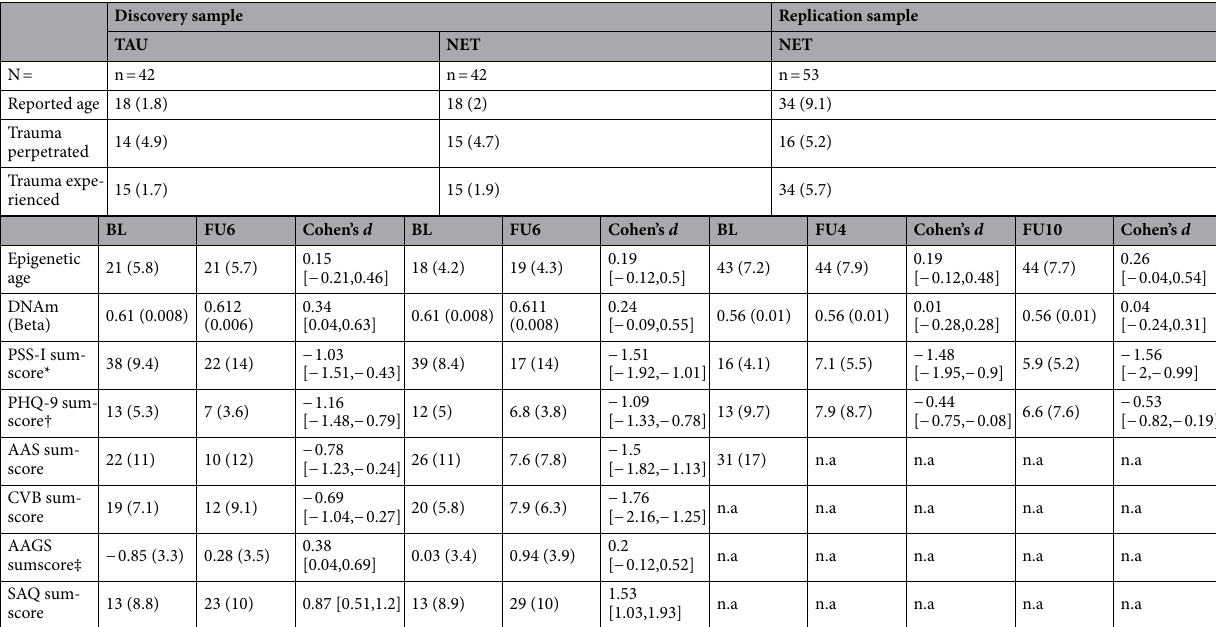
Table 1. Summary statistics of the discovery and replication samples. Sample size, reported age, nr. of traumatic events (perpetrated and experienced), epigenetic age, DNAm (Beta), and sumscores for PTSD (PSS-I), depression (PHQ-9), appetitive aggression (AAS), current violent behaviour (CVB), feelings of guilt (AAGS) and social acknowledgement (SAQ) are shown. Except for sample size, all values are reported as means with standard deviations in parentheses. Cohen’s d effect sizes are reported with a 95% bootstrap confidence interval in square brackets. BL: baseline; FU4,6,10: follow-ups after 4, 6 and 10 months from baseline, respectively; *PDS Scale was used for replication sample; † HSCL Scale was used for replication sample; ‡sumscores of AAGS are scaled; n.a.: not available.